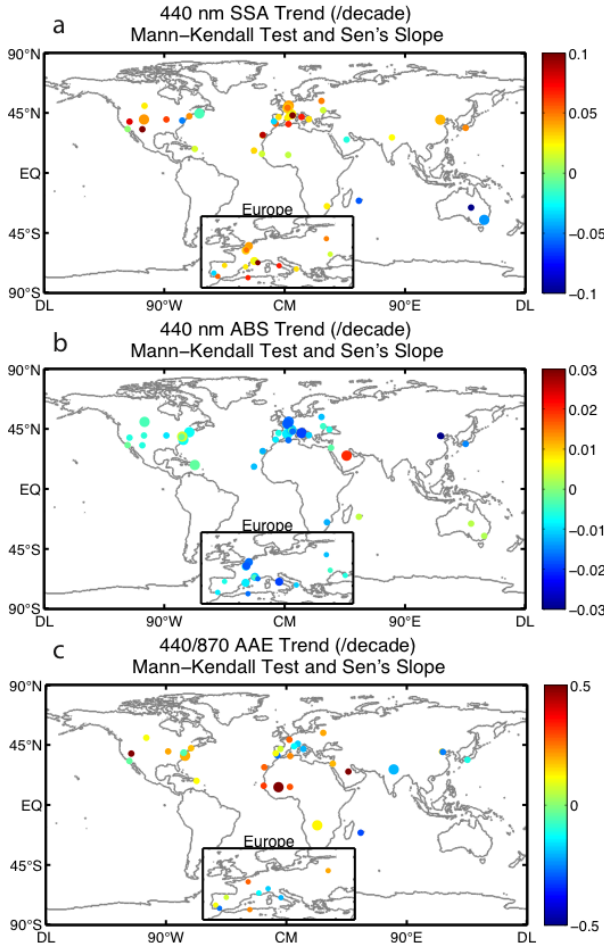
Figure 10. Global and regional 440nm AOD distributions using data from the 90 stations used here in the AOD and AE trend study. The smaller panels in the upper right show an enlargement of the [0, 0.5] AOD interval. The black dashed line marks the posi- tion of AOD = 0.4, which is the quality control threshold used for AERONET level 2.0 inversion product.